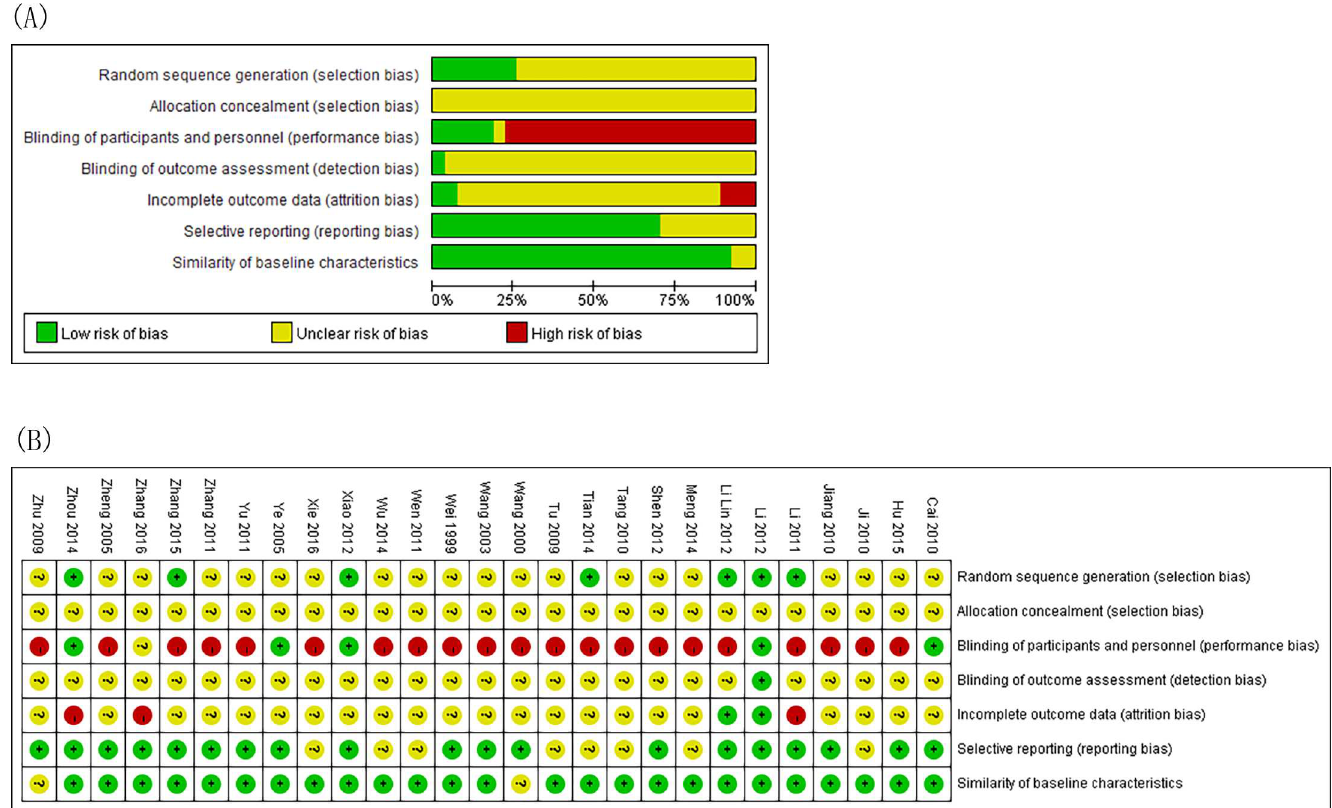
Fig 2. The risk of bias assessment with the Cochrane Collaboration tool. (A)Risk of bias graph. (B)Risk of bias